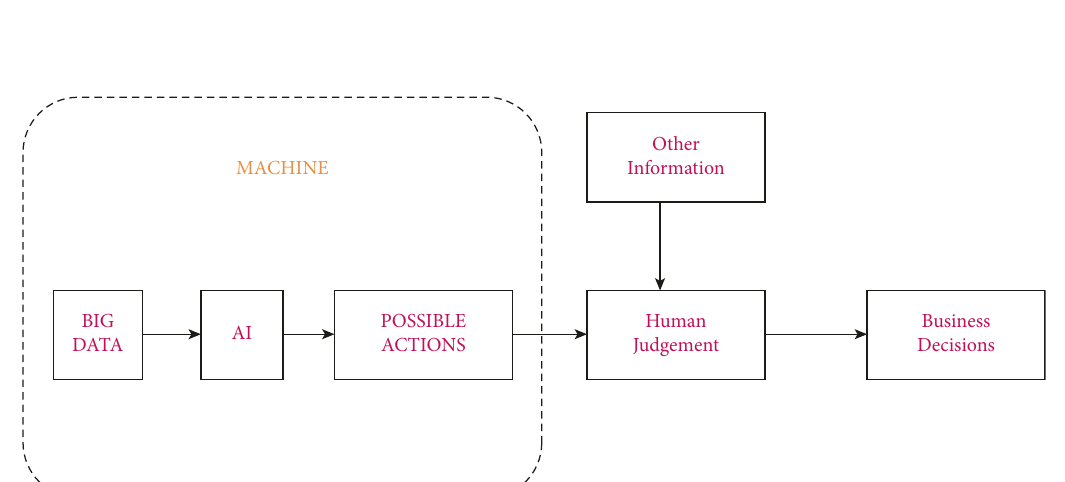
Figure 1: AI-driven workflow.